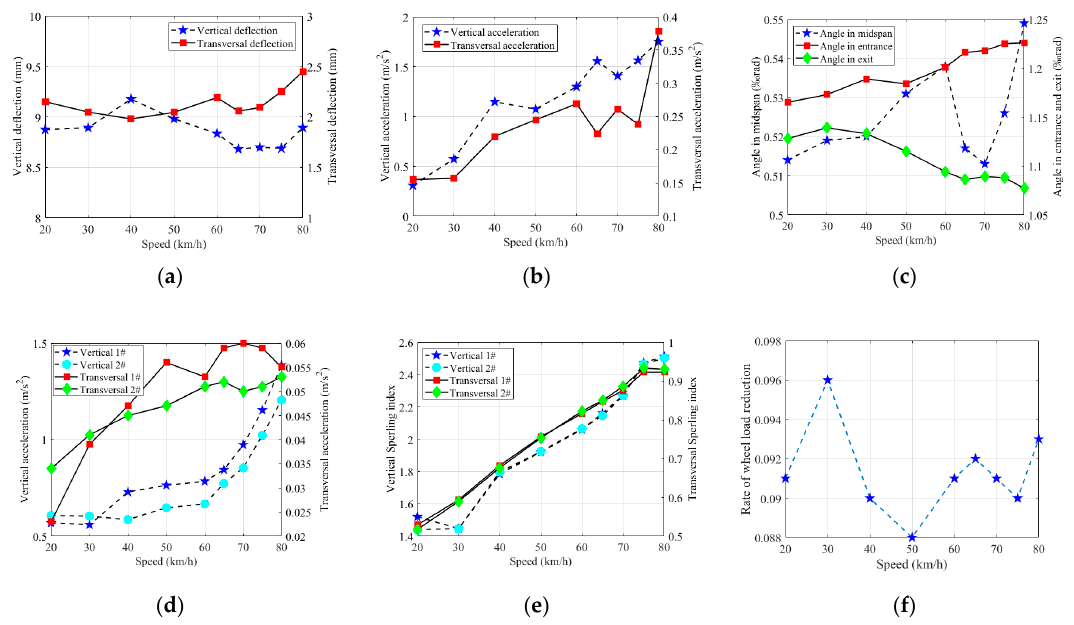
Figure 10. Responses of the bridge and the train under different speeds: ( a ) bridge deflection, ( b ) bridge acceleration, ( c ) bridge angle, ( d ) train acceleration, ( e ) Sperling index, and ( f ) rate of wheel load reduction.